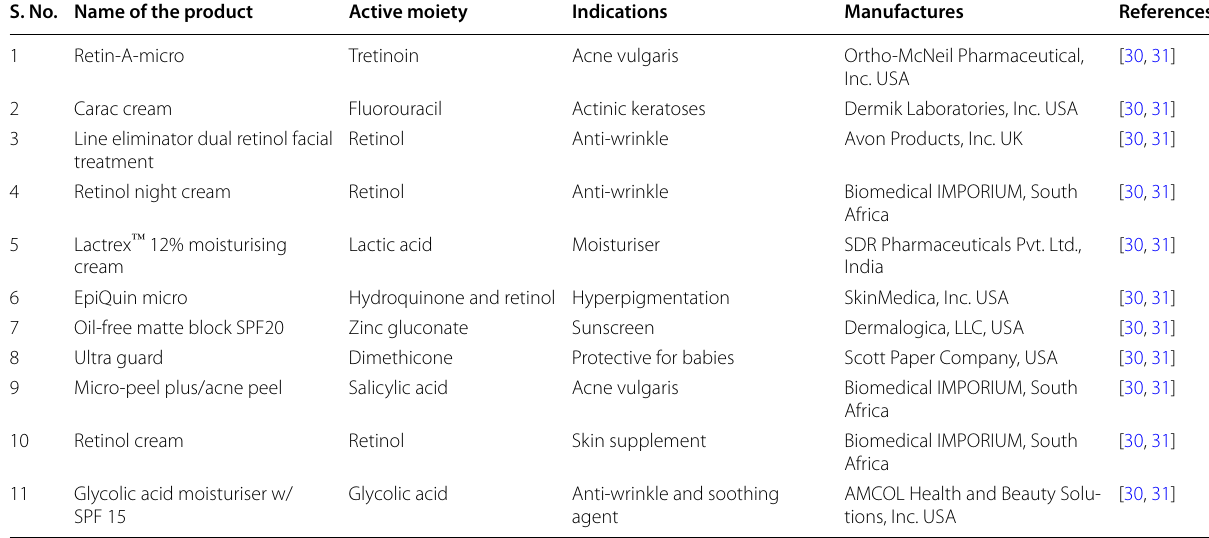
Table 3 Some examples of MDS currently marketed as cosmetic products S. No. Name of the